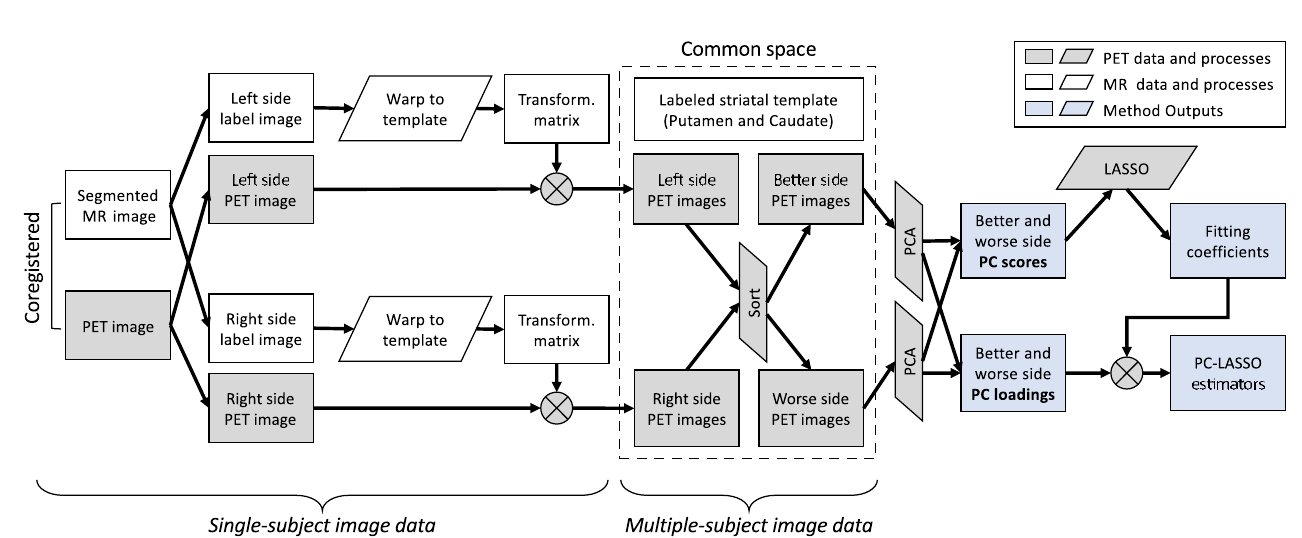
Fig 1. Schematic illustration of the image processing and analysis pipeline. Parametric PET images of the left and right striatum were warped to a common space using an MR-derived striatal template. In the common space, the images were re-sorted according to the better (less clinically affected) and worse sides, and used in PCA to obtain side-specific PC loadings and PC scores. The PC loadings and scores in the putamen and caudate were analyzed separately. LASSO was used to obtain the fitting coefficients between the PC scores and clinical PD metrics—aDD and LMS. Using the fitting coefficients, the PC loadings were linearly combined to obtain the PC-LASSO